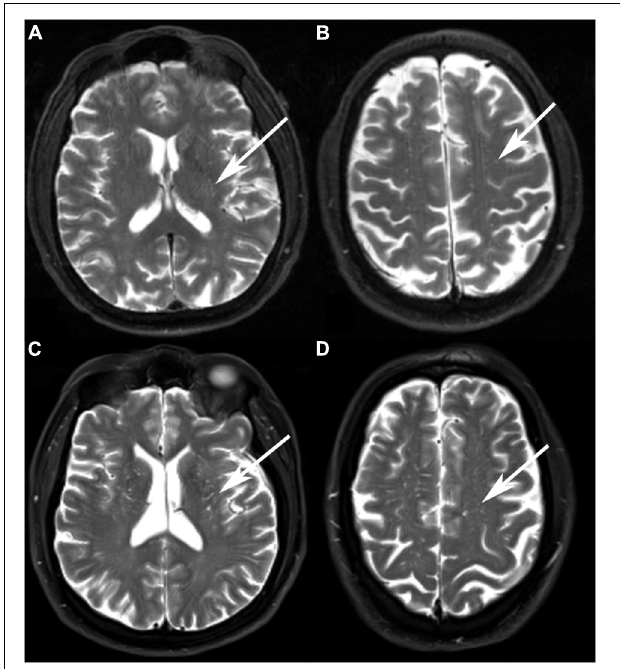
FIGURE 2 | Examples of MRI-visible perivascular spaces. (A,B) A 68-year-old Vietnam war veteran without a history of traumatic brain injury (TBI) had a low degree of BG-PVS and CSO-PVS. (C,D) A 67-year-old Vietnam War veteran with a history of TBI had a high degree of BG-PVS and